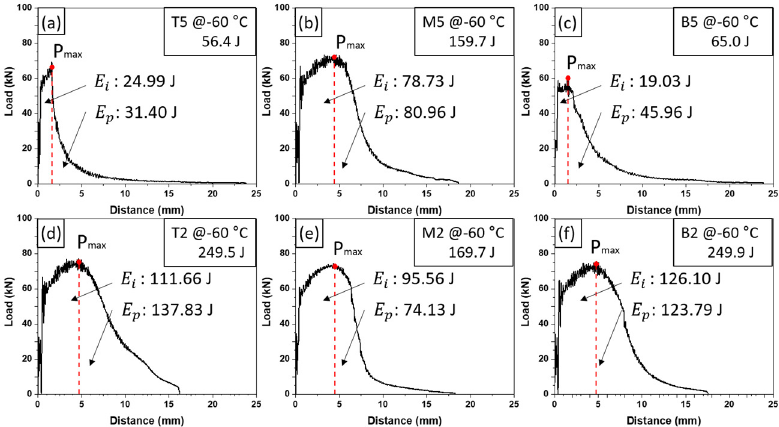
Figure 8. Force (kN)–displacement (mm) curves obtained for instrumented Charpy impact tests at − 60 °C: ( a ) 5 mm from F.L. of top, ( b ) 5 mm from F.L. of middle, ( c ) 5 mm from F.L. of bottom; ( d ) ( d ) 2 mm from F.L. of top, ( e ) 2 mm from F.L. of middle, ( f ) 2 mm from F.L. of 2 mm from F.L. of top, ( e ) 2 mm from F.L. of middle, ( f ) 2 mm from F.L. of bottom.